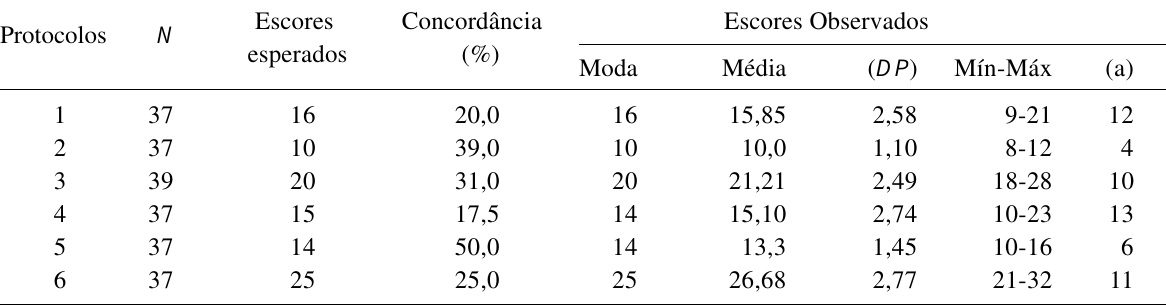
Figueiredo, V. L. M., Araújo, L. M. G., Dias, T. C. & Busetti, M. V. (2010). Subtestes Semelhanças, Vocabulário e Compreensão do WISC-III: Pontuação Objetiva ou